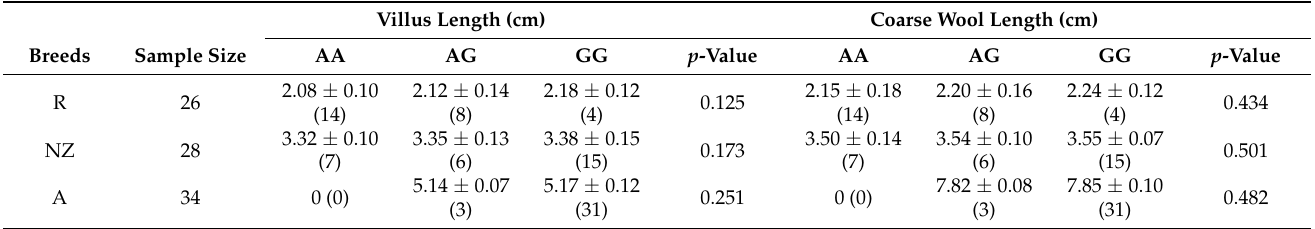
Table 2. Association analysis of WIF1 genotypes and wool length traits in the three rabbit breeds. Villus Length (cm) Coarse Wool Length